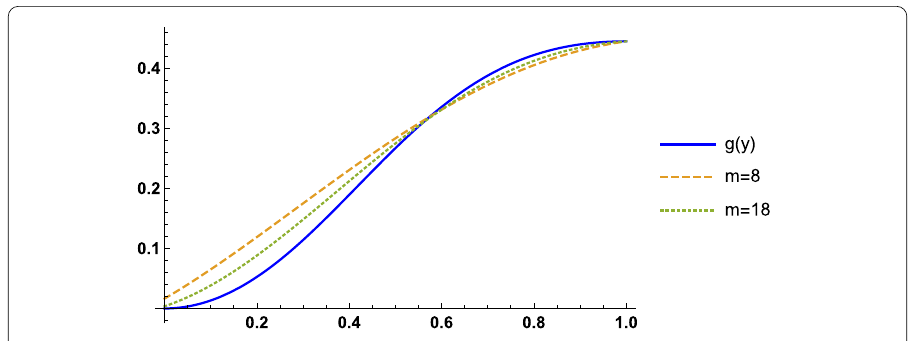
Figure 4 Convergence of operators for some m values